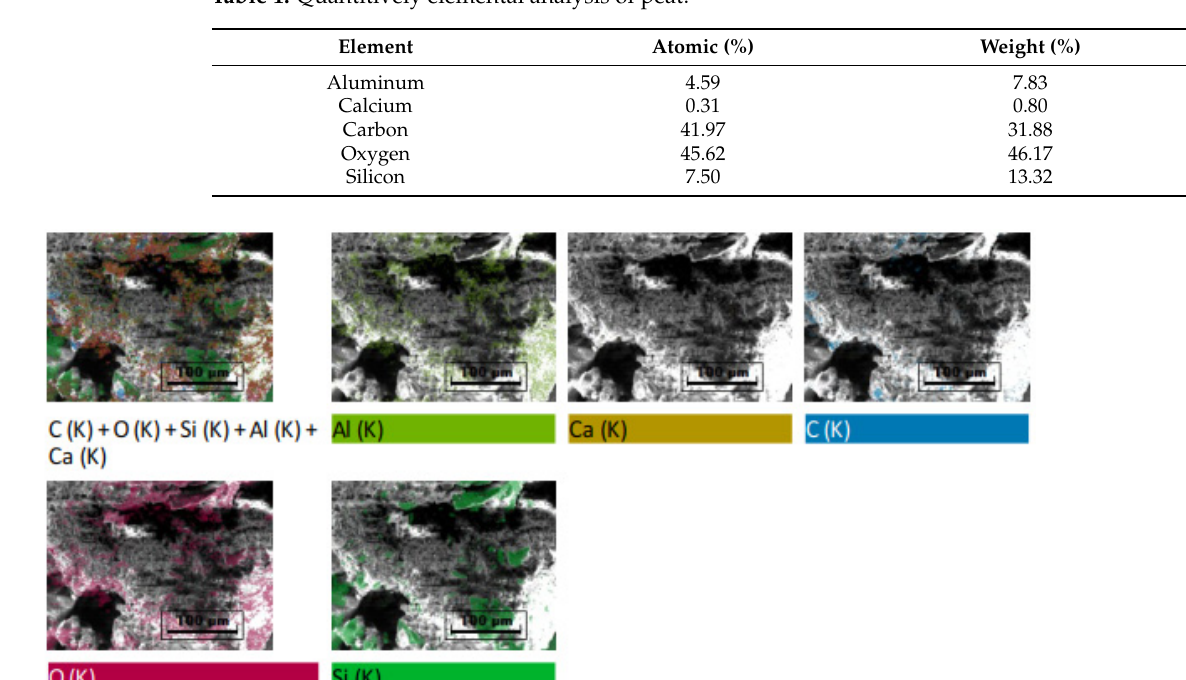
Figure 1. Elemental images of peat from EDX mapping.